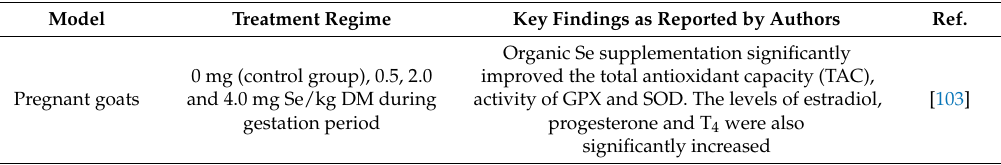
Table 4. Effects of maternal dietary Se supplementation on oxidative stress, antioxidant activity, embryo development and reproductive